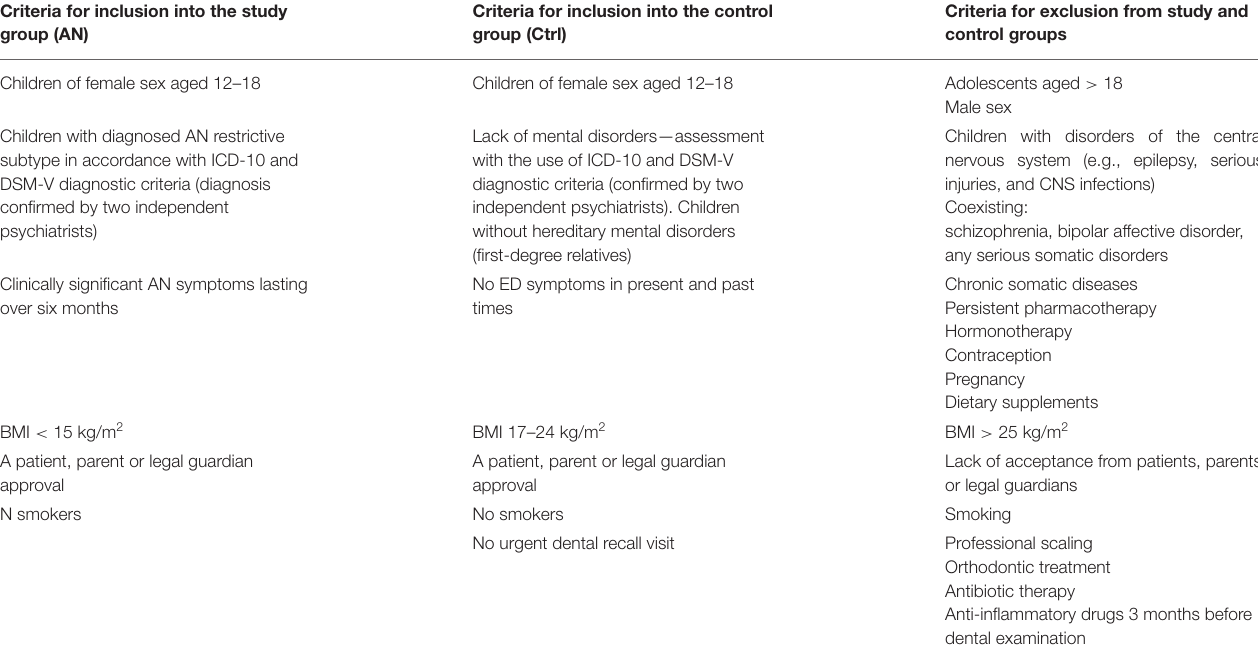
Criteria for inclusion into the control group (Ctrl)